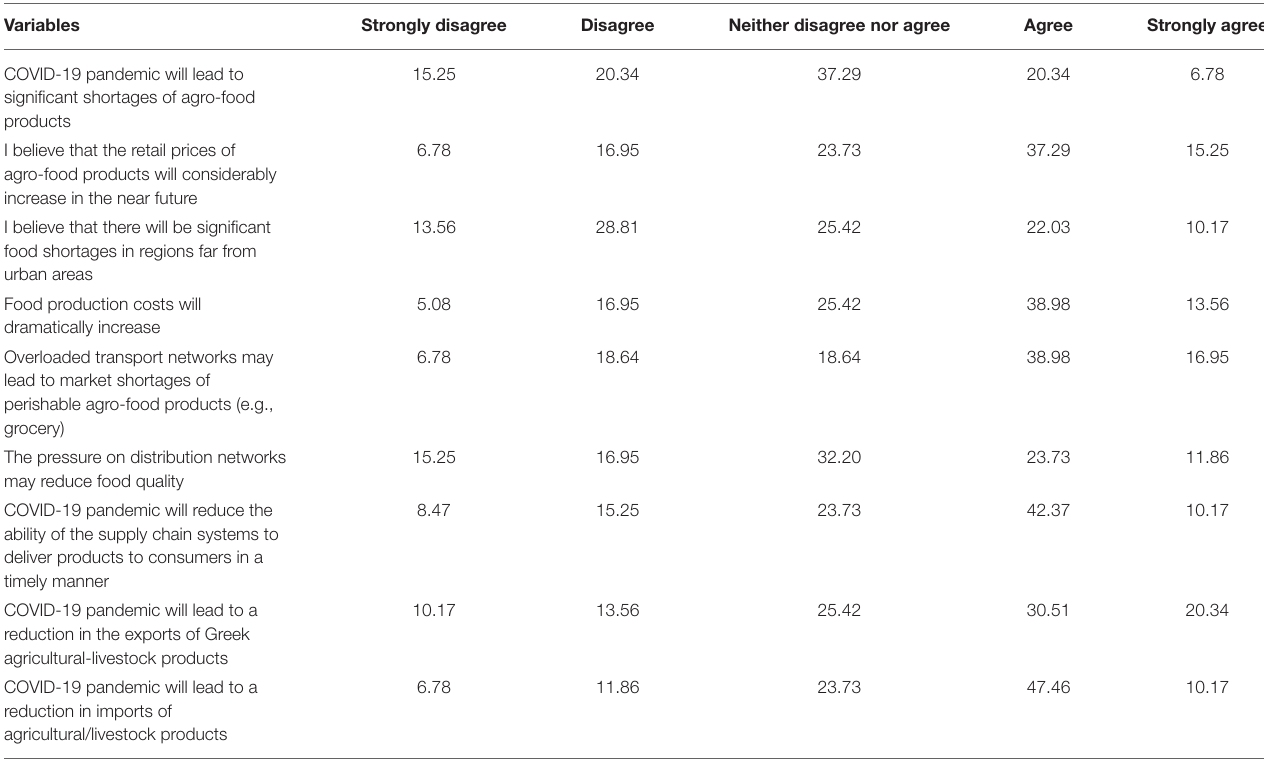
TABLE 6 | Experts’ perceptions toward COVID-19 impact on food distribution networks (%). Variables Strongly disagree Disagree Neither disagree nor agree Agree Strongly